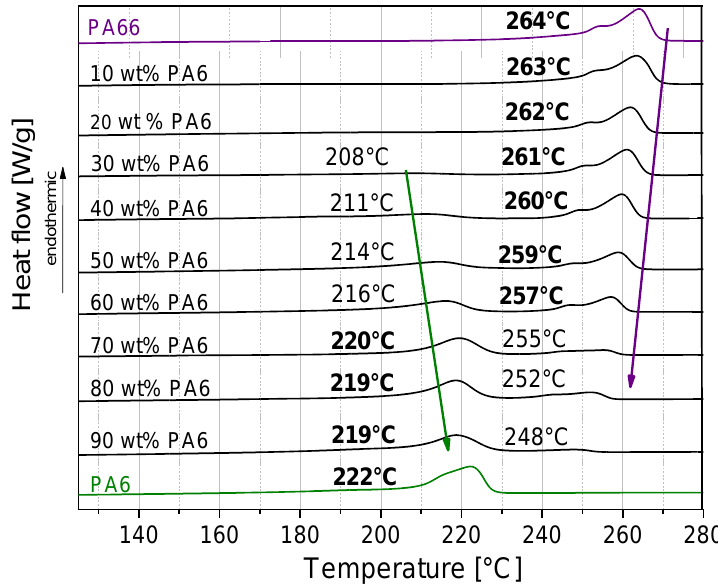
Figure 2. Melting behavior and melting temperatures T m at different PA6/PA66 blend compositions.